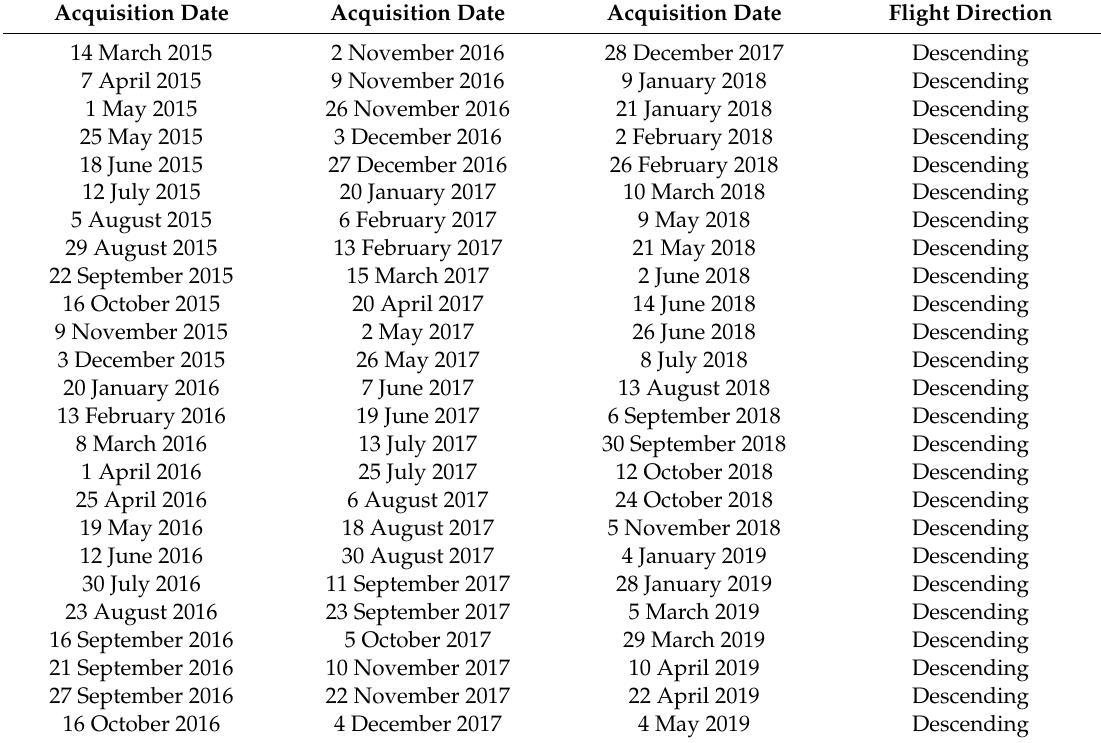
Table 1. Sentinel-1A data used in the study